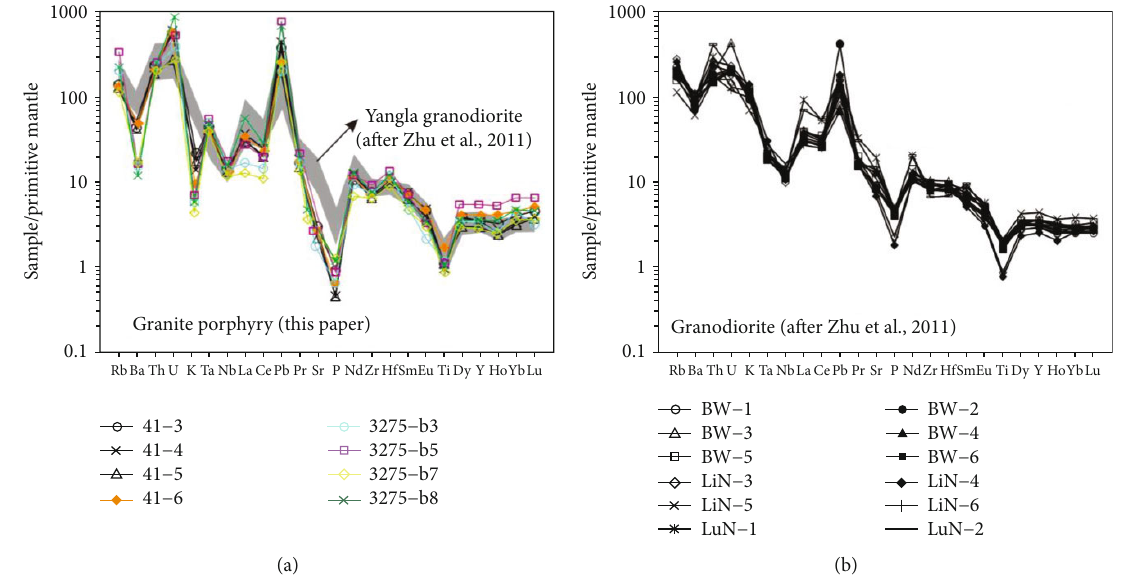
Figure 13: Primitive mantle-normalized spider diagram of the granite porphyries and granodiorite in Yangla copper deposit, Yunnan, China (after Sun and Mcdonough, 1989